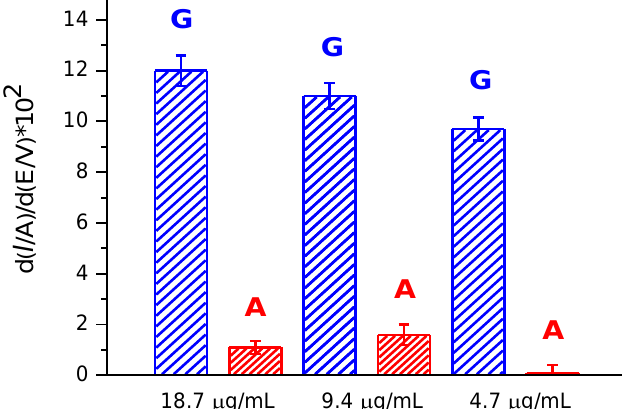
Figure 7. The current intensities of the differentiated DPV peaks for electrooxidation of the guanine (blue) and adenine (red) residues for 18.7, 9.35, and 4.7 µ g / mL leukocyte DNA solutions assayed with the SPE / (P n BMA 40 - b -PDMAEMA 120 + MWCNT_2) construct. Incubation time after DNA deposition was 60 min. First derivatives of the DPV raw data were used for calculating the given intensity values.